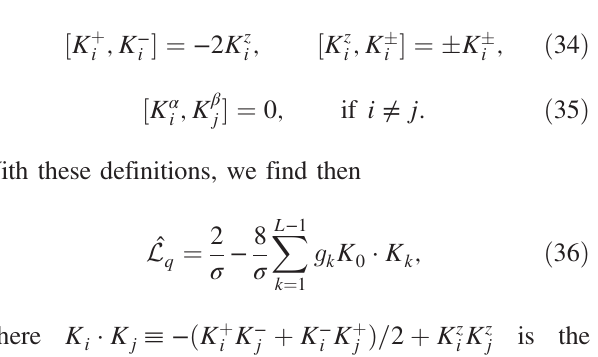
FIG. 1. Depiction of a one-dimensional quantum walk, with a local control at the bottom rung. Each site of the chain is coherently coupled with its nearest neighbors. Random control pulses are applied to the first